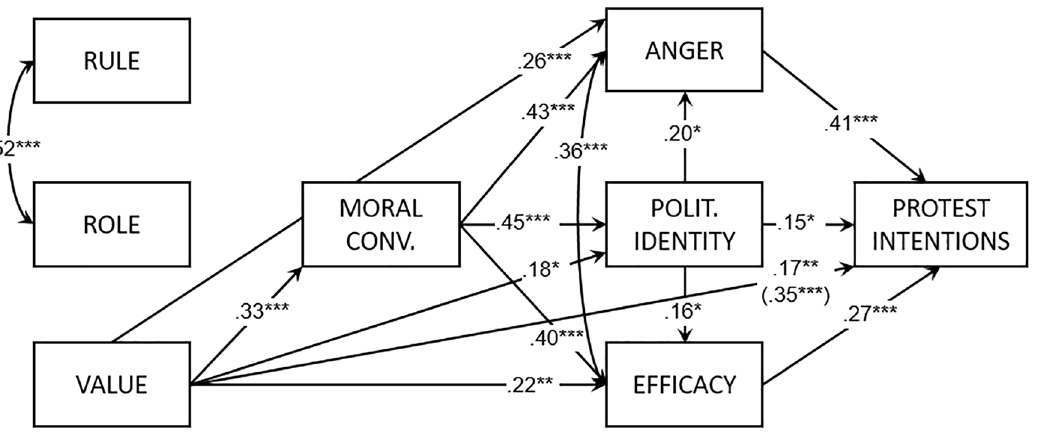
Figure 1. Path model of Study